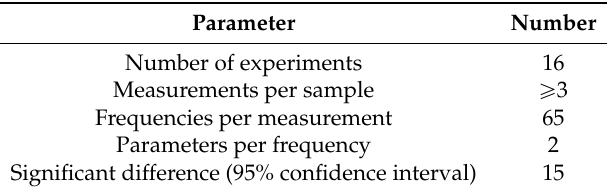
Table 1. Statistics of the results of the WCM tapwater treatment. In each experiment, 65 frequencies between 100 Hz and 10 Mhz were